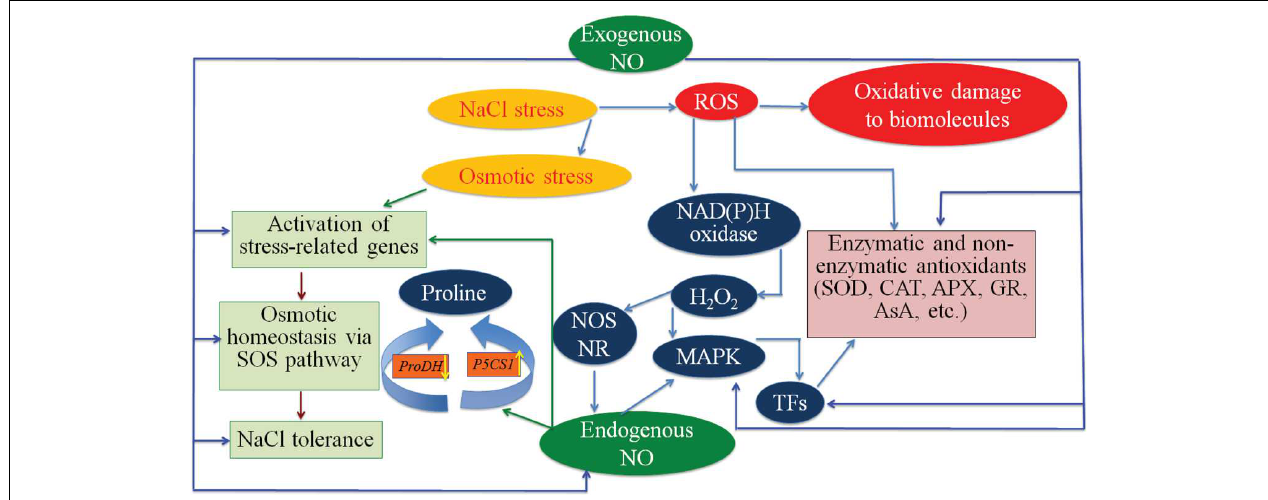
FIGURE 5 | Potential mechanisms of NaCl stress mitigation by application of exogenous NO. Excessive NaCl causes osmotic and oxidative stresses in plants. Salt stress induces ABA accumulation, which promotes H 2 O 2 generation through NAD(P)H oxidase. Stress-induced H 2 O 2 triggers generation of endogenous NO by activating NR (nitrate reductase) and NOS (nitric oxide synthase)-like enzymes. Exogenous application of NO to plants may enhance the biosynthesis of endogenous NO, as well as that of antioxidant enzymes through MAPK (mitogen-activated protein kinase) and other unknown signaling pathways. Exogenous NO supplementation to plants can also up-regulate genes involved in proline synthesis, such as P5CS1 , and other stress-related genes responsible for NaCl tolerance, whereas it might down-regulate ProDH that is involved in proline catabolism. Exogenous NO treatment may also help balance osmotic homeostasis in plants under salt stress via the SOS (salt overly sensitive) pathway, by increasing plasma membrane H + -ATPase activity. APX, ascorbate peroxidase; AsA, ascorbic acid; CAT, catalase; GR, glutathione reductase; H 2 O 2 , hydrogen peroxide; P5CS1 , δ 1-pyrroline-5-carboxylate synthetase ; ProDH , proline dehydrogenase ; ROS, reactive oxygen species; SOD, superoxide dismutase; TFs, transcription